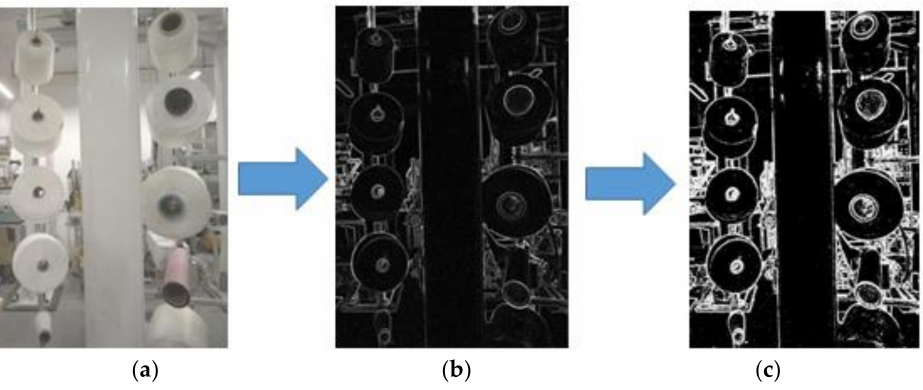
Figure 5. This figure shows image processing. ( a ) Raw grayscale image. ( b ) Gradient image. ( c ) Binary